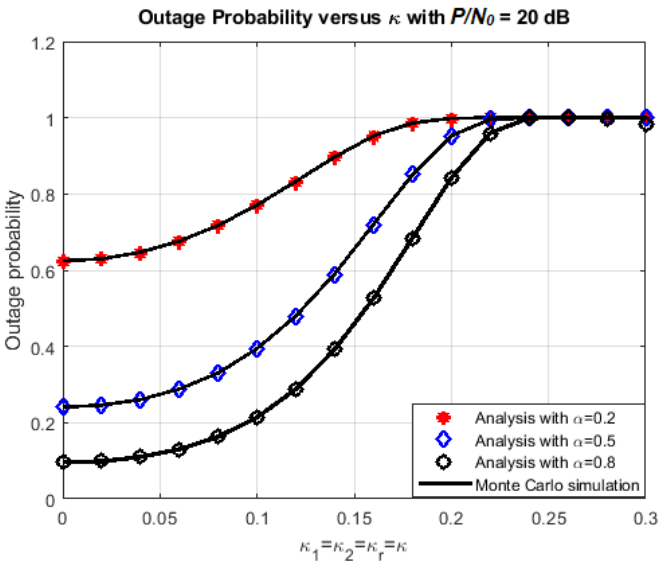
Figure 5. Outage probability versus κ